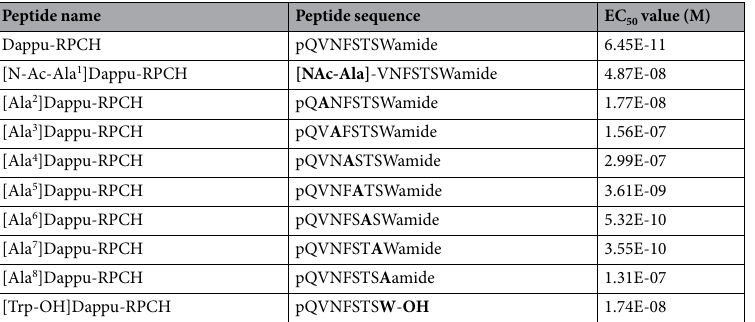
Table 2. Analogues of Dappu-RPCH tested on the Daphnia pulex RPCH receptor in in vitro bioluminescence assays and the resulting EC 50